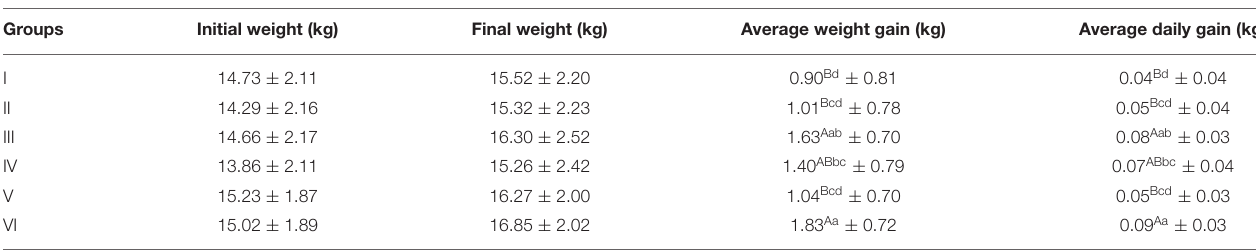
TABLE 7 | Changes of average body weight of lambs in each